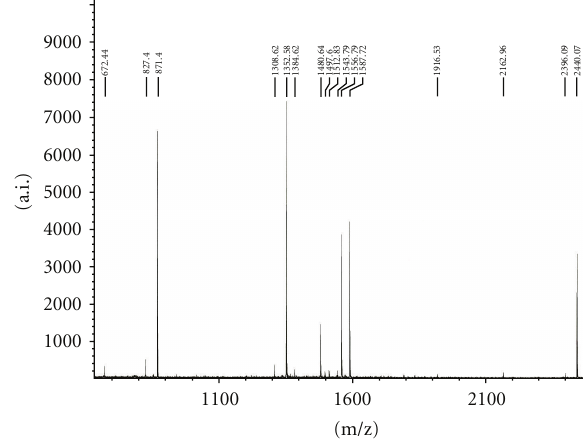
Figure 8: Peptide mass fingerprinting map of protein spot